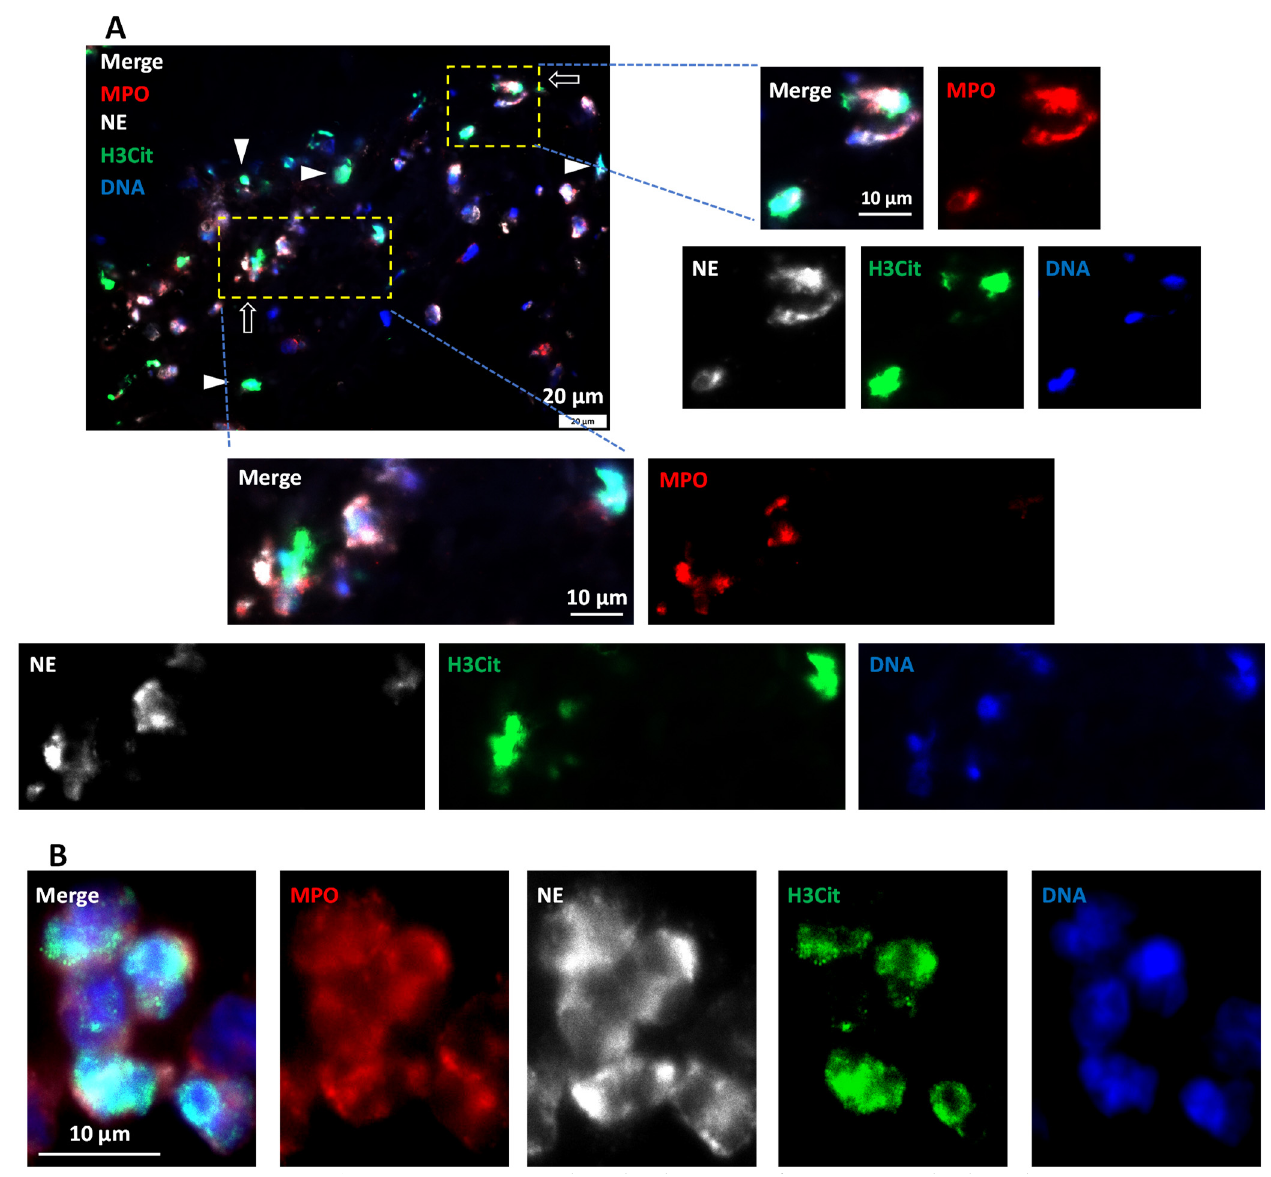
Figure 8. AIS patient thrombi show NET formation in platelet-rich areas. ( A ) Representative immunofluorescent image of ischemic stroke patient thrombi stained for DNA (blue), and with antibodies against neutrophils (MPO, red, and NE, white) and citrullinated histone (H3Cit, green). Neutrophils are seen at different NET-forming stages (white arrows). Moreover, visible are extracellular NETs (white arrowheads) depicting complete NETosis. Scale bar: A: 20 μ m and insets: 10 μ m. ( B ) Representative ischemic stroke patient thrombi at higher magnification show NET-forming neutrophils with nuclear decondensation and marked with intracellular H3Cit staining. Scale bar: 10 µ